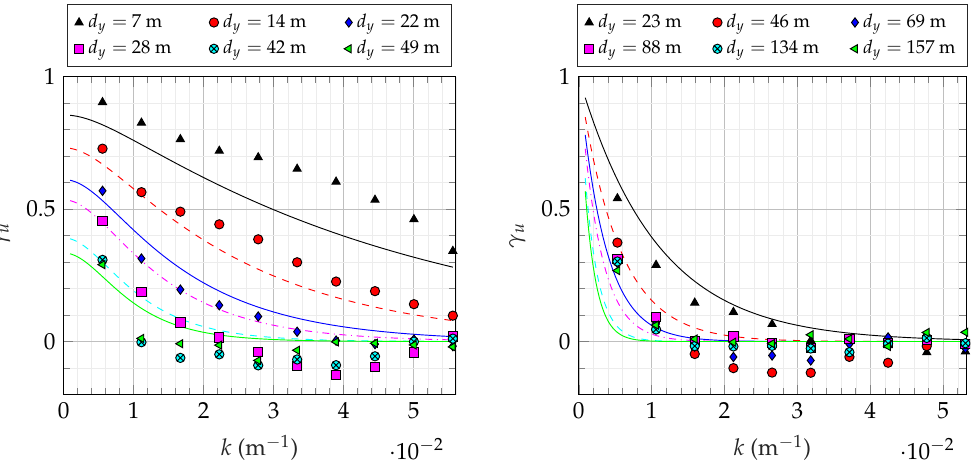
Figure 13. Measured (markers) and fitted (Equation (15), lines) co-coherence using data recorded by the four scanning beams of LE only (E-W configuration), at a scanning distance r = 500m ( left panel , using 84 samples) and r = 1600m ( right panel , using 93 samples), with 10 m from 18 May 2016 to 21 June